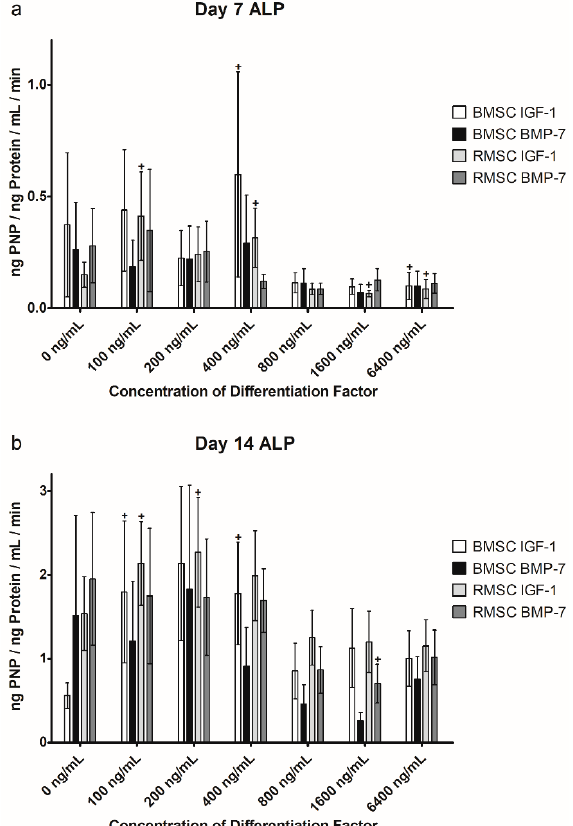
Figure 4. Comparison of the alkaline phosphatase (ALP) activity between MSC stimulated with IGF-1 or BMP-7, again showing day 7 ( a ) and 14 ( b ) separately for increased clarity. Results are displayed as bar graphs with the standard error of the mean shown as whiskers above and below each